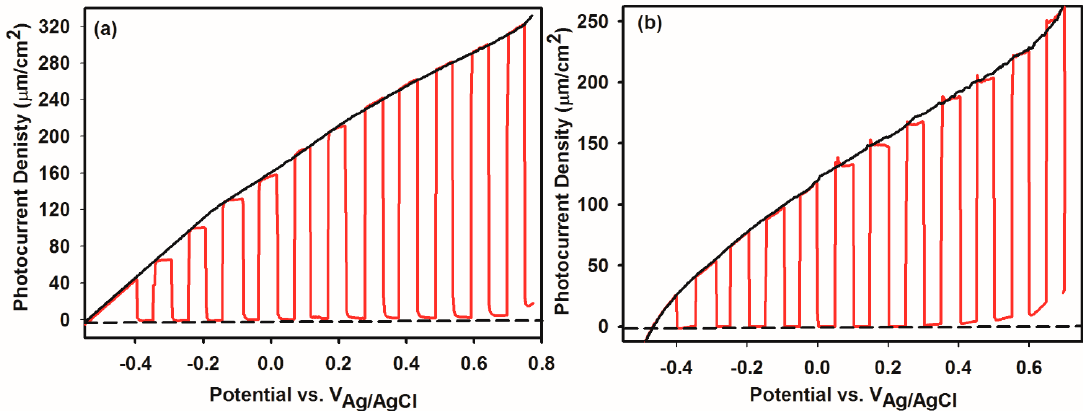
Figure 6. Current–voltage characteristics ( a ) for Hierarchical buckyball-shaped microsphere structured and ( b ) for nanoplates structured for Bi 2 WO 6 electrodes deposited by AACVD. The light was physically chopped to reveal light and dark current concurrently.